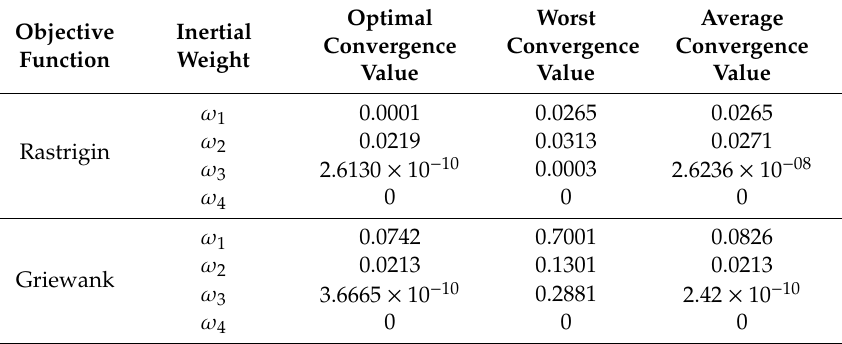
Table 1. Parameter settings.